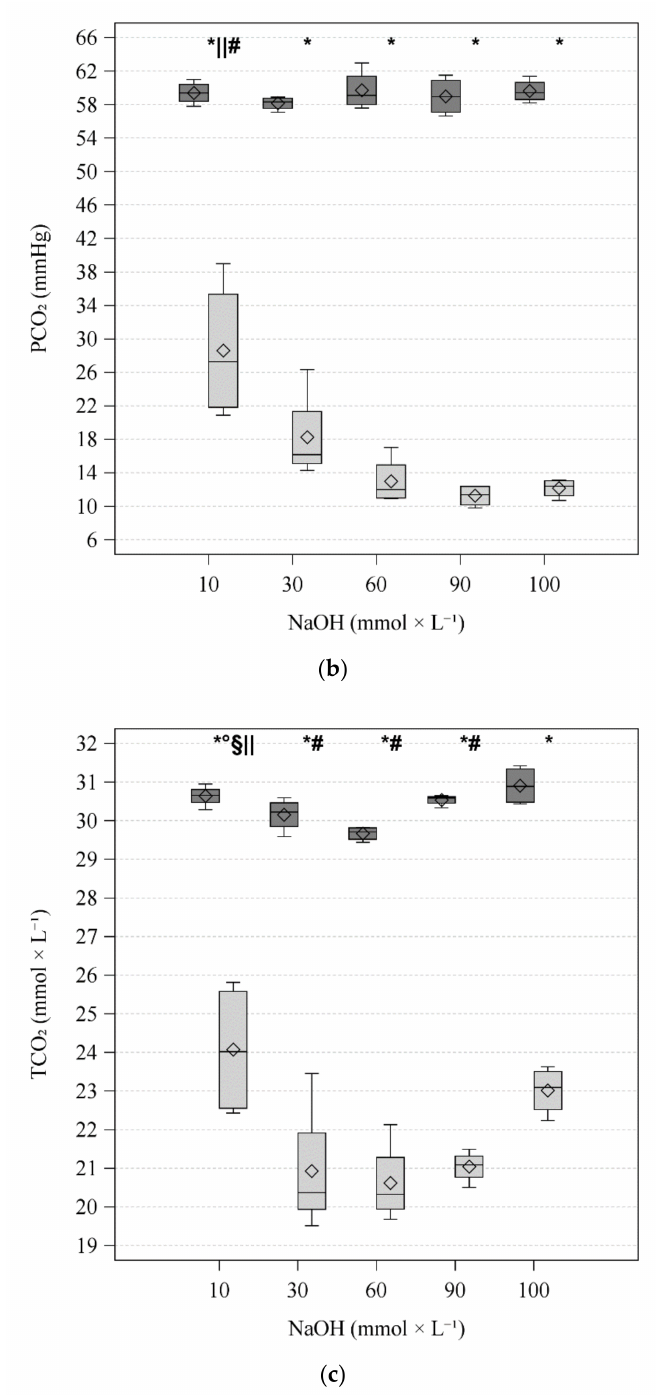
Figure 3. Figures display the distribution of data by using a rectangular box plot and whiskers, the bottom and top edges of the box indicate the intra-quartile range (IQR) between the first and third quartiles (the 25th and 75th percentiles). The diamond marker inside the box indicates the mean value. The line inside the box indicates the median value. Whiskers indicate the range of values outside of the intra-quartile range but at a distance lower than the upper and lower fences ( ± 1.5 × IQR). Dark grey represents PRE blood sampling. Light grey represents POST blood sampling. Statistical analysis: Two-way ANOVA RM (TCO 2 ) or two-way ANOVA RM on ranks (pH and PCO 2 ). * p < 0.05 vs. PRE; ◦ p < 0.05 vs. 30; § p < 0.05 vs. 60; || p < 0.05 vs. 90; # p < 0.05 vs. 100. ( a ) pH distribution according at different NaOH concentrations; ( b ) PCO 2 (partial pressure of carbon dioxide) distribution at different NaOH concentrations. ( c ) TCO 2 (Carbon dioxide content) distribution at different NaOH